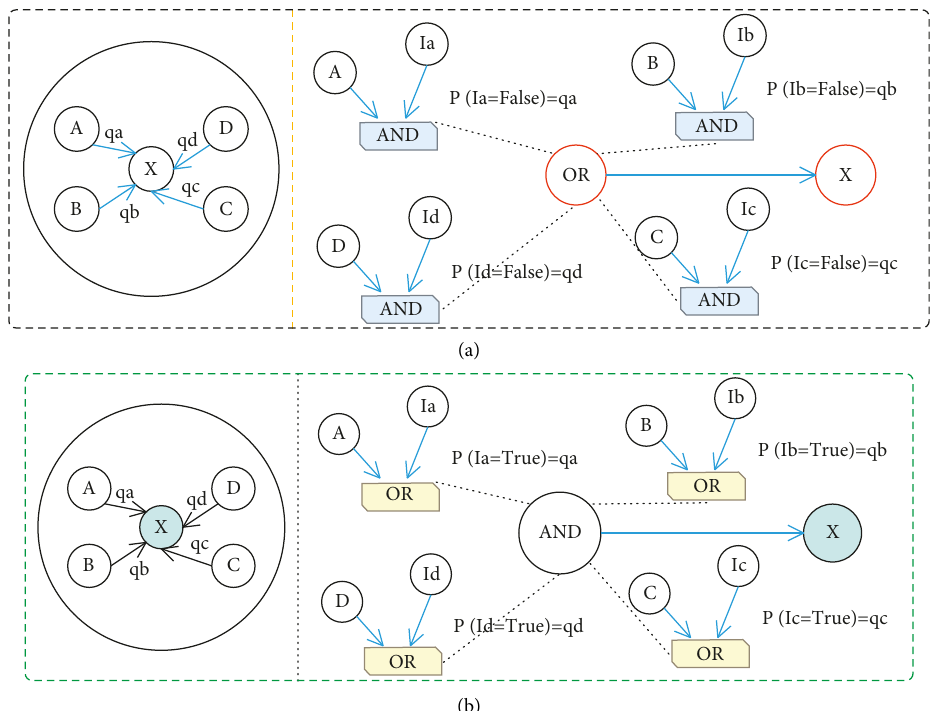
Figure 2: Comparison of the conceptual view of the Noisy-OR node and the conceptual view of the Noisy-AND node. (a) Conceptual view of Noisy-OR node. (b) Conceptual view of Noisy-AND